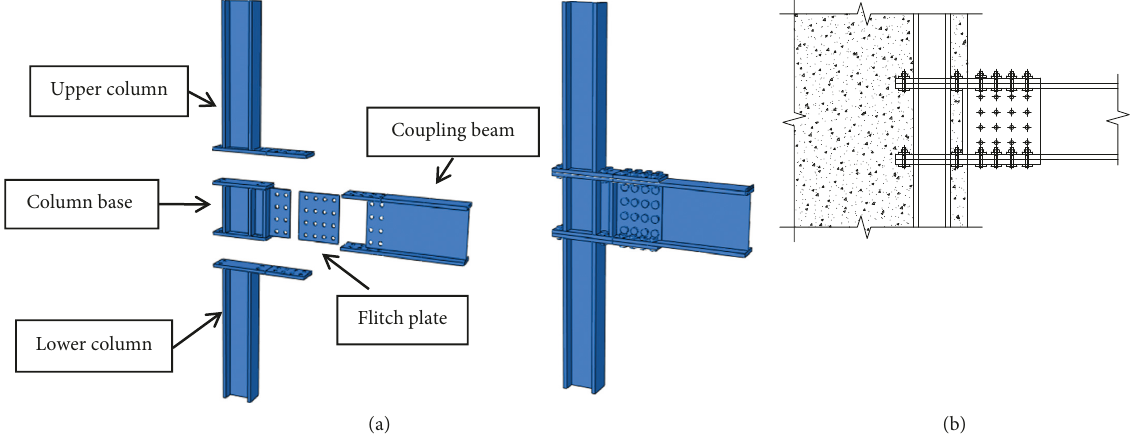
Figure 2: Sketch of the modular prefabricated HCW system. (a) Structural diagram of the connection. (b) Details of the connection.